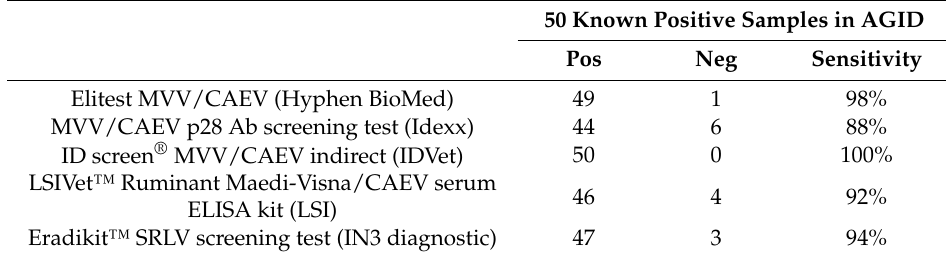
Table 3. Additional evaluation of enzyme-linked immunosorbent assays (ELISA)